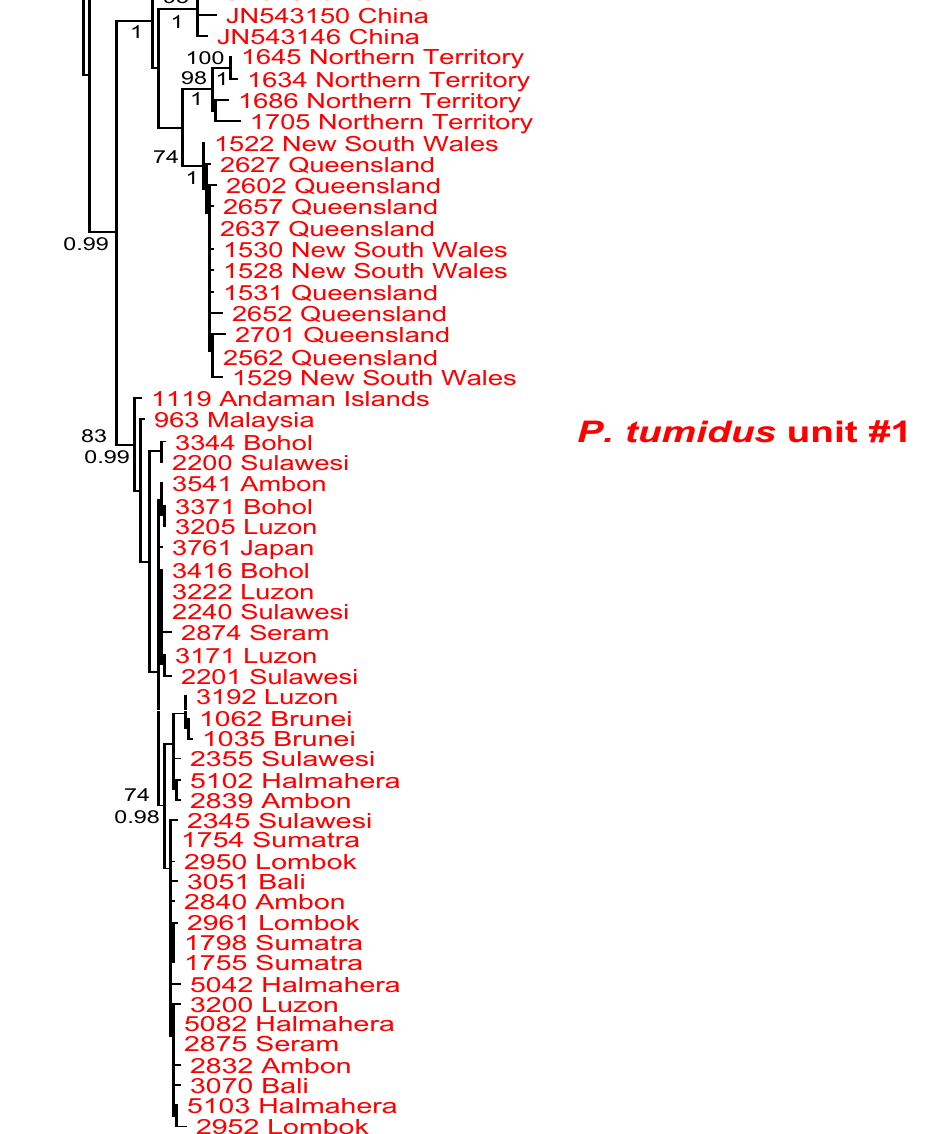
Fig. 2. (continued) Phylogenetic relationships within Paromoionchis gen. nov. based on COI sequences of 166